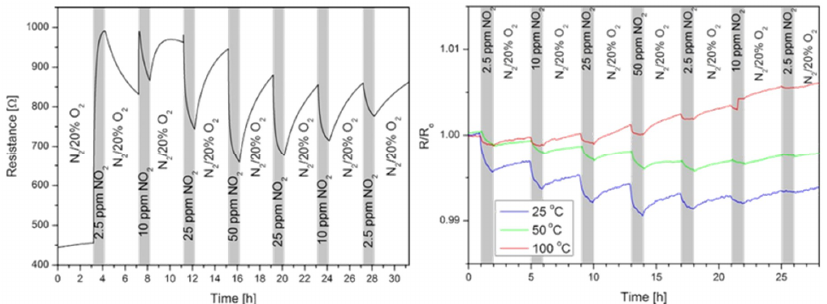
Figure 5. Left panel present response of single layer graphene exposed different concentrations of NO 2 . Right panel present response of multilayer graphene exposed to different concentrations of NO 2 tested in different temperature. Reproduced with permission from ref. [83].